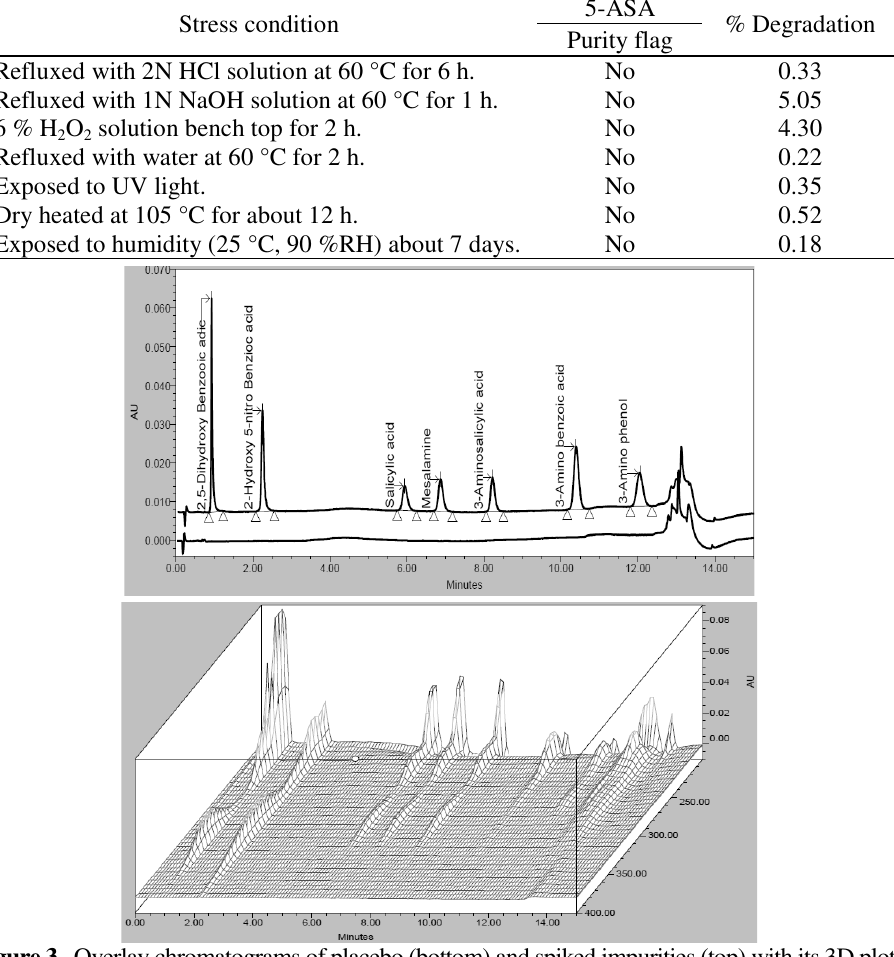
5-ASA % Degradation Purity flag